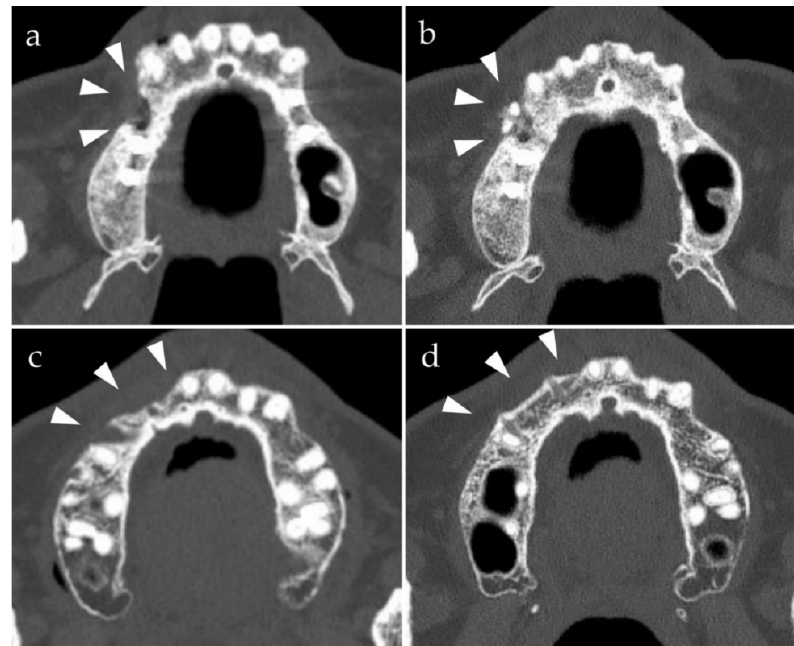
Figure 1. Preoperative and postoperative computed tomography axial images of bone augmentation using u-HA/PLLA and u-HA/PLLA/PGA (arrowheads, bone augmentation site). The density of the u-HA/PLLA screws is greater than that of the u-HA/PLLA/PGA screws. ( a ) Before placement of u- HA/PLLA screws; ( b ) 6 months after the placement of u-HA/PLLA screws; ( c ) before placement of b ) 6 months after the placement of u-HA/PLLA screws; ( c ) before placement u-HA/PLLA/PGA screws; ( d ) 6 months after placement of u-HA/PLLA/PGA screws. u-HA/PLLA screws; ( of u-HA/PLLA/PGA screws; ( d ) 6 months after placement of u-HA/PLLA/PGA